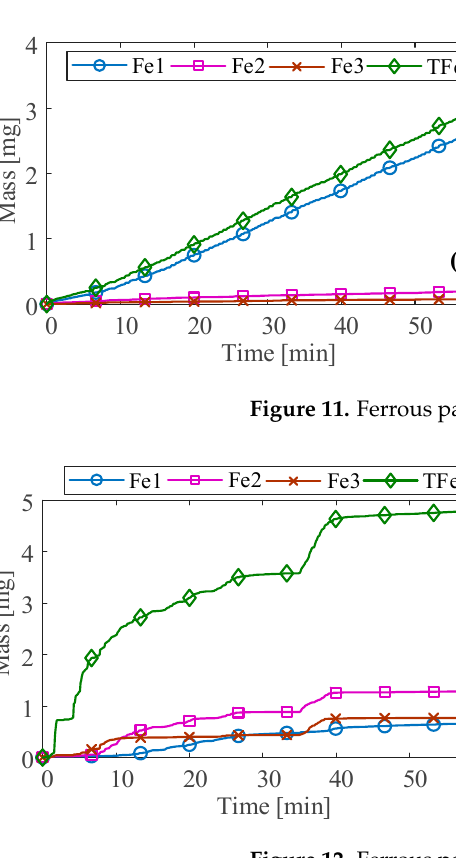
and Fe4 size ranges, indicating that the ferrous debris caused by the abrasive wear mainly existed in the three size ranges.